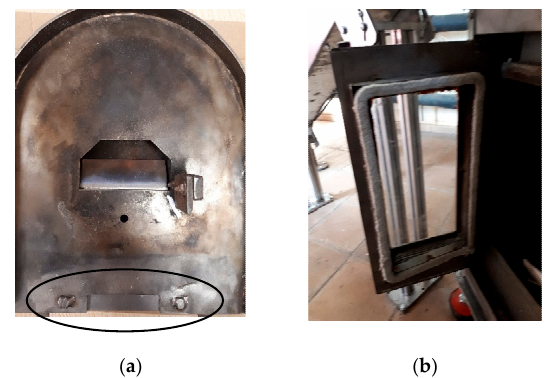
Figure 12. Improvements on the furnace cover ( a ) and extra isolating layer ( b ).